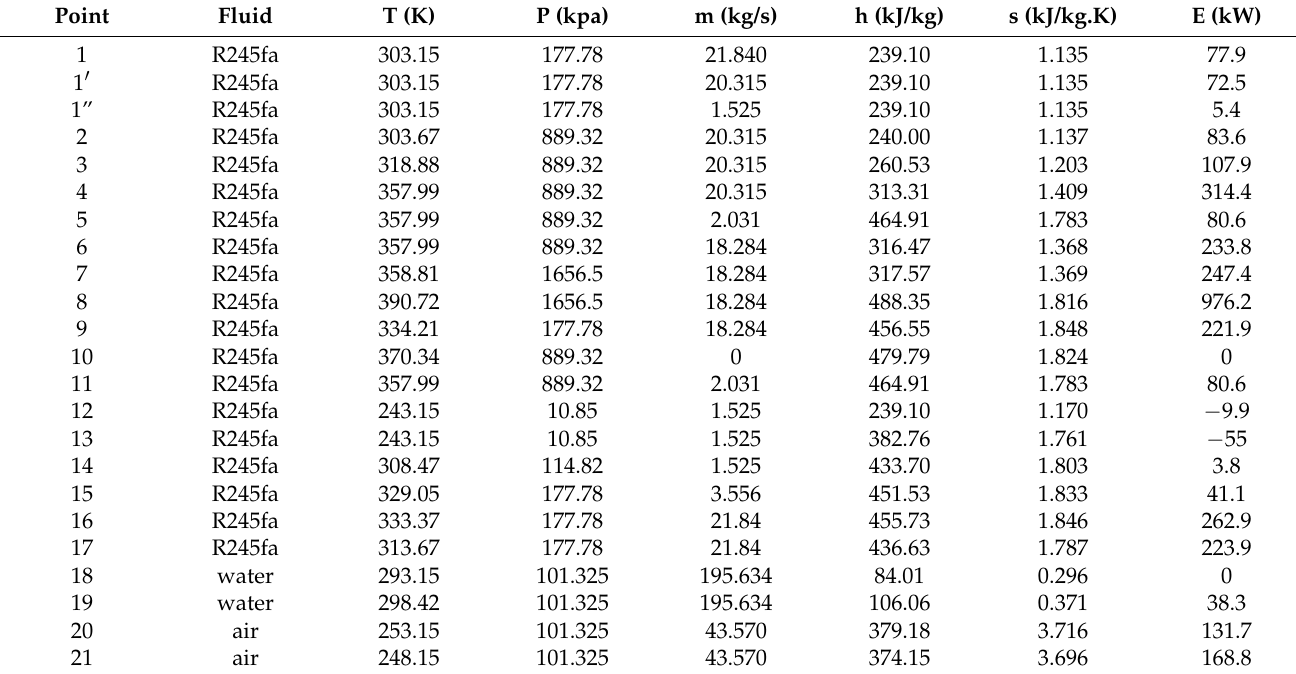
Table 9. Parameters of each state point under optimized working conditions.